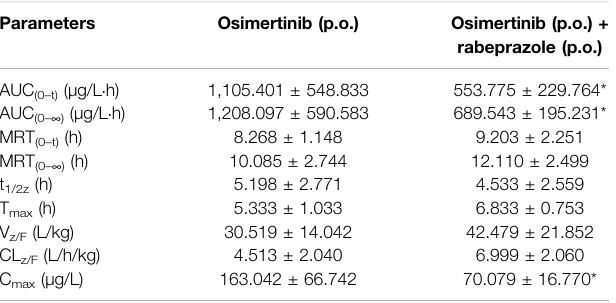
TABLE 3| Themainpharmacokineticparameters ofAZ5104intwogroupsofrats ( N = 6).